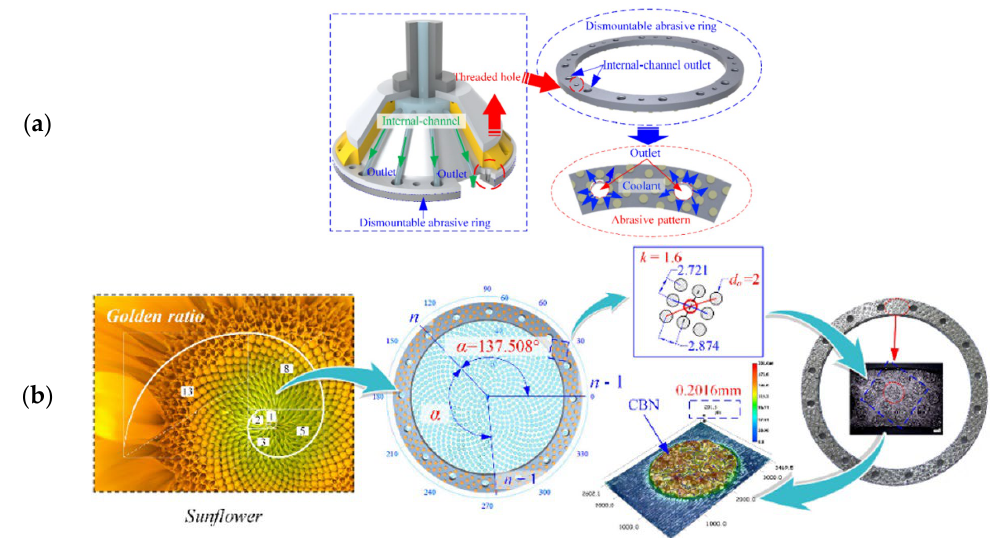
Figure 9. ( a ) Structure of the internal-cooling grooved grinding wheel and ( b ) the abrasive ring with the phyllotactic pattern of the abrasive [76].